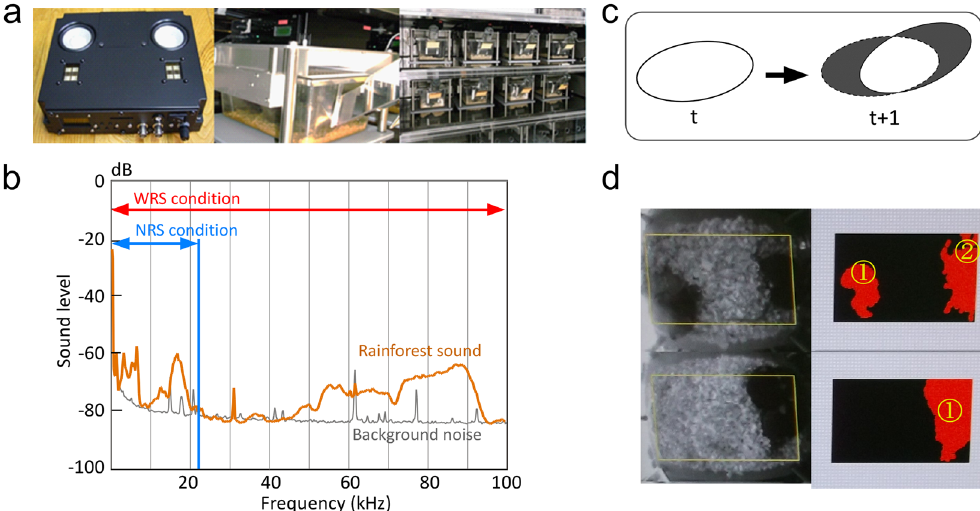
Figure 5. Experimental settings and behaviour measures. ( a ) Sound emission system fixed at the top of each cage. ( b ) Power spectrum of sounds emitted through the speakers for WRS (wide range of sounds) and NRS (narrow range of sounds) conditions. Orange and grey lines indicate the frequency power spectra of rainforest sounds and background noise, respectively. ( c ) Measurements of voluntary movement and the particle number. Shadows of animals in the field of view were detected as particles. Voluntary movement was determined as exclusive or (exclusive disjunction) as particle areas from time t to time t + 1 . ( d ) The number of particles was recorded as an index of the degree of animals forming aggregations. Voluntary movement and particle number were monitored for each cage